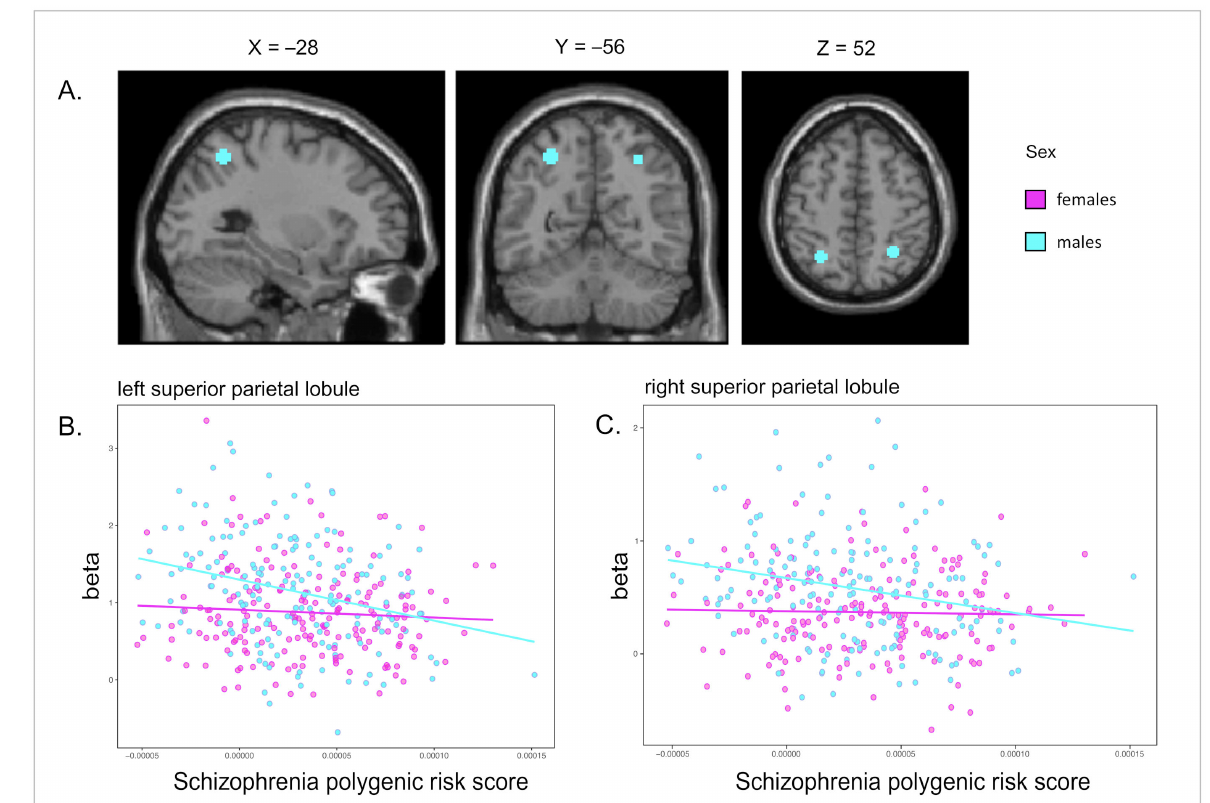
Figure 2. Association between schizophrenia PRS and altered brain activity during episodic memory retrieval in males and females at baseline. ( A ) PRS associated with hypoactivation in the bilateral superior parietal lobule during episodic memory retrieval (voxel threshold: 10, p -value threshold 0.001 uncorrected in regions-of-interest). The association was significant in males only ( p = 0.00007 in left and p = 0.00044 in right superior parietal lobule). ( B , C ) Corresponding scatterplot based on the peak activity associated with PRS in the left ( B ) and right ( C ) superior parietal lobule. As an additional analysis, we examined sex interactions in FWE-corrected whole brain analyses during WM and EM at baseline. During EM retrieval, these analyses confirmed a significant interaction with schizophrenia PRS and sex in the right SPL ( t -value = 5.02, p -value FWE-corrected : 0.003) as well as in the right ventral diencephalon ( t -value = 4.54, p -value FWE-corrected : 0.033), while no significant effects were seen during EM encoding